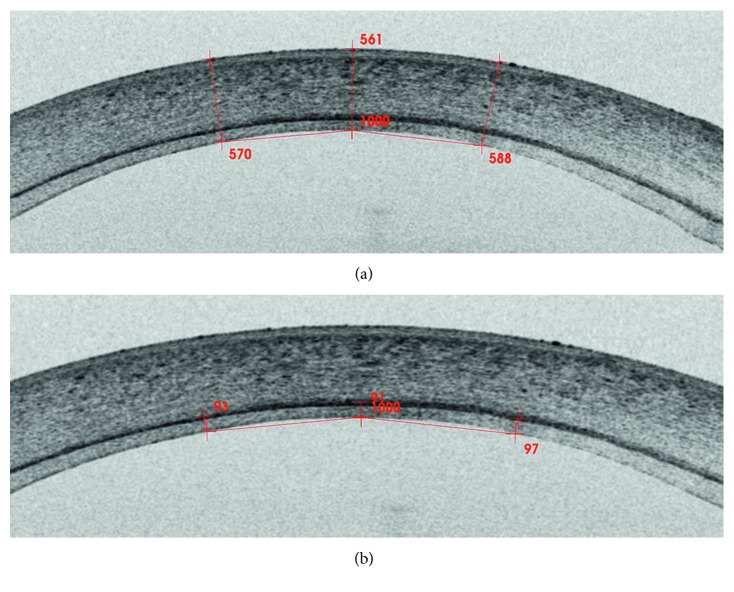
Thickness of a DSAEK graft as measured on an AS-OCT image. Both total (a) and graft (b) corneal thickness were measured at 5 points (at the point of intersection of the measurement's reference axis and the graft and at 1 mm distance in the superior, inferior, nasal, and temporal meridian). Here are depicted three horizontal points: at the point of intersection of the measurement's reference axis and the graft, and at 1 mm distance on both sides nasally and temporally to the centre.